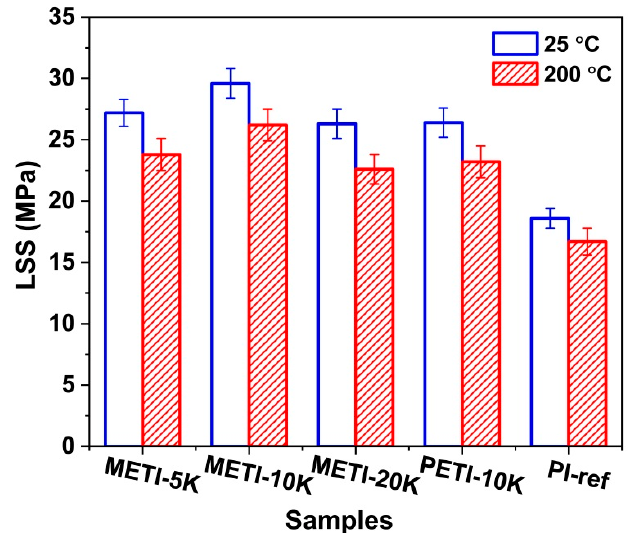
Figure 12. Lap shear strength (LSS) of electrospun METI fiber membranes for bonding stainless steel sheets. Table 4. Bonding strength of METI NFM adhesives.